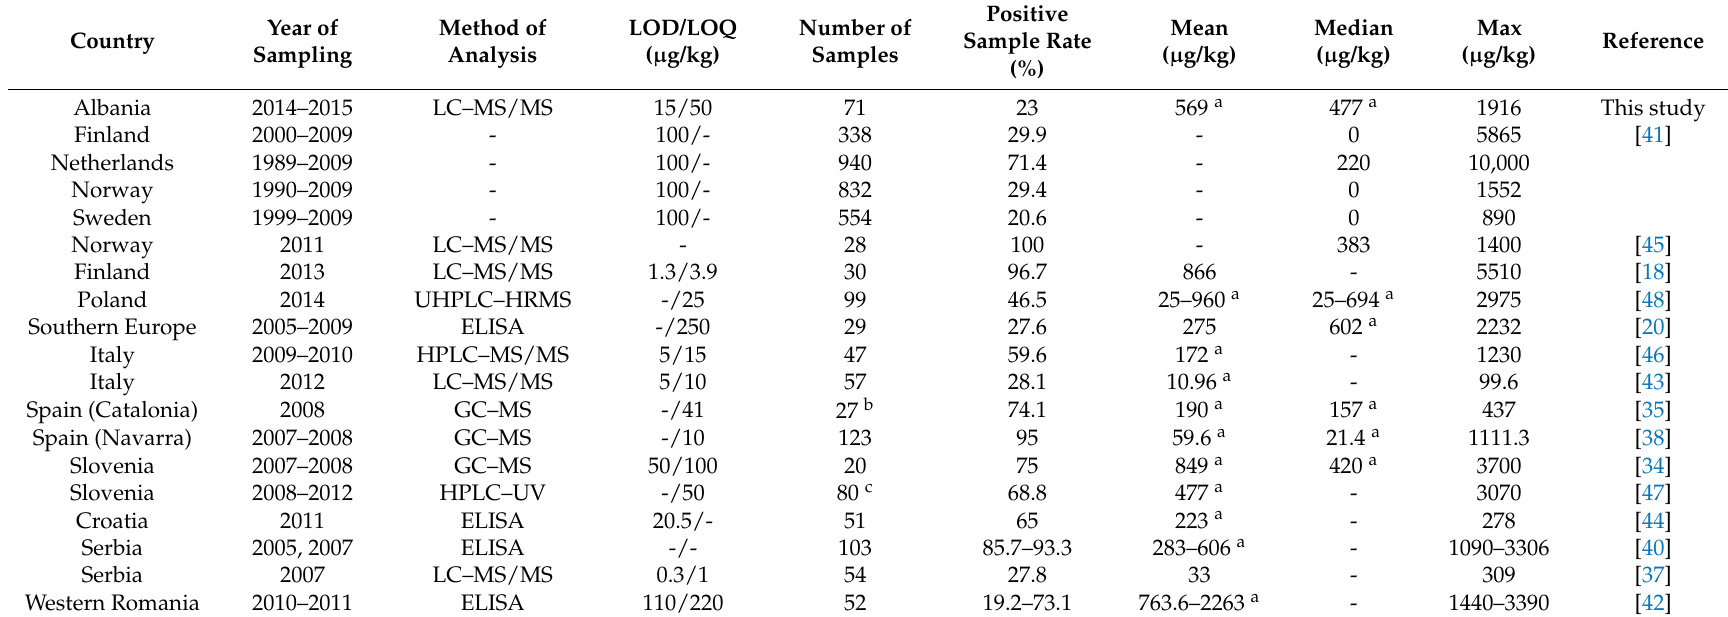
Table 5. Occurrence of DON in wheat from different